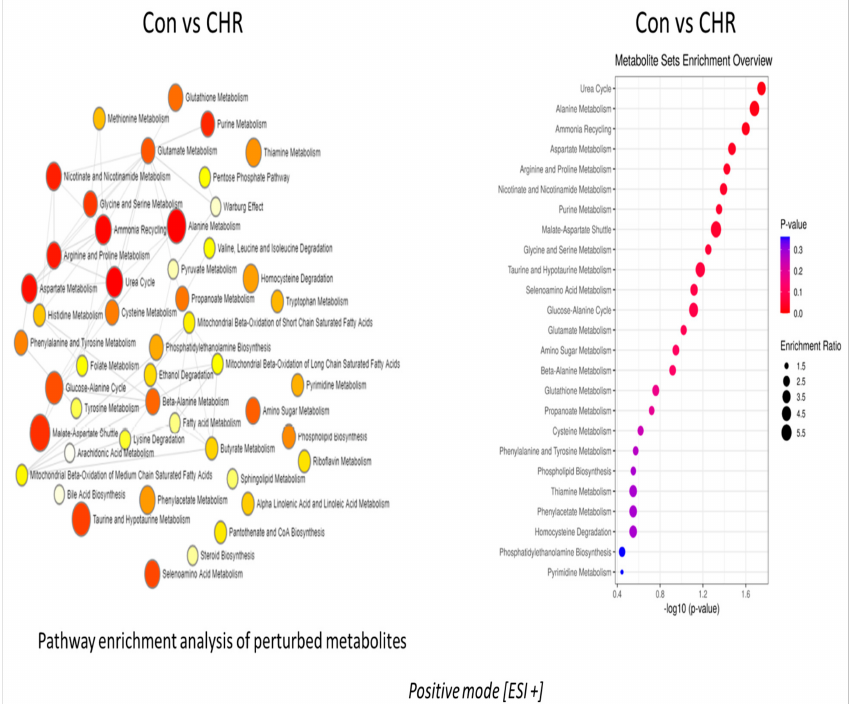
Figure 7. Chrysin-regulated pathways in positive ion mode. The enrichment pathway analysis along with the enrichment ratio in the positive ion mode are clearly